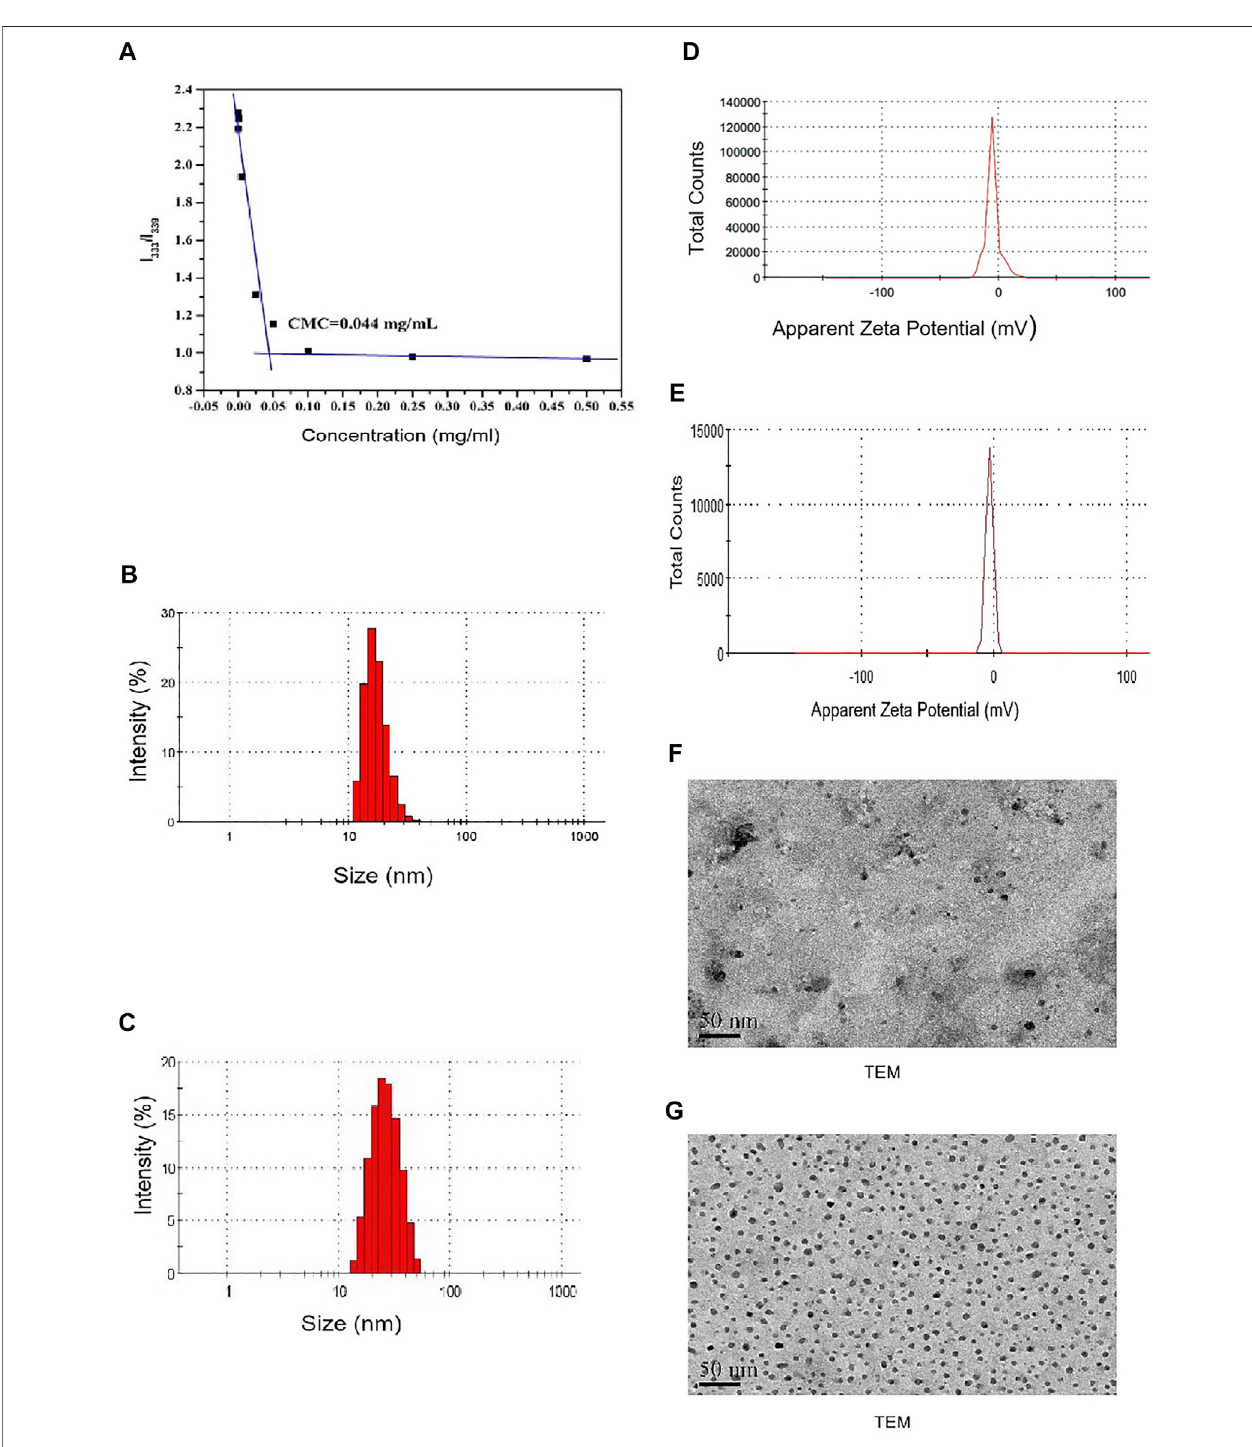
FIGURE 2 | Characterization of DTX-mPEG-PDLLA micelles. (A) CMC measurement of mPEG-PDLLA by a pyrene fl uorescence probe. (B,C) Particle size distribution of mPEG-PDLLA and DTX-mPEG-PDLLA micelles. (D,E) Zeta potential of mPEG-PDLLA and DTX-mPEG-PDLLA micelles. (F,G) TEM images of mPEG- PDLLA and DTX-mPEG-PDLLA micelles.